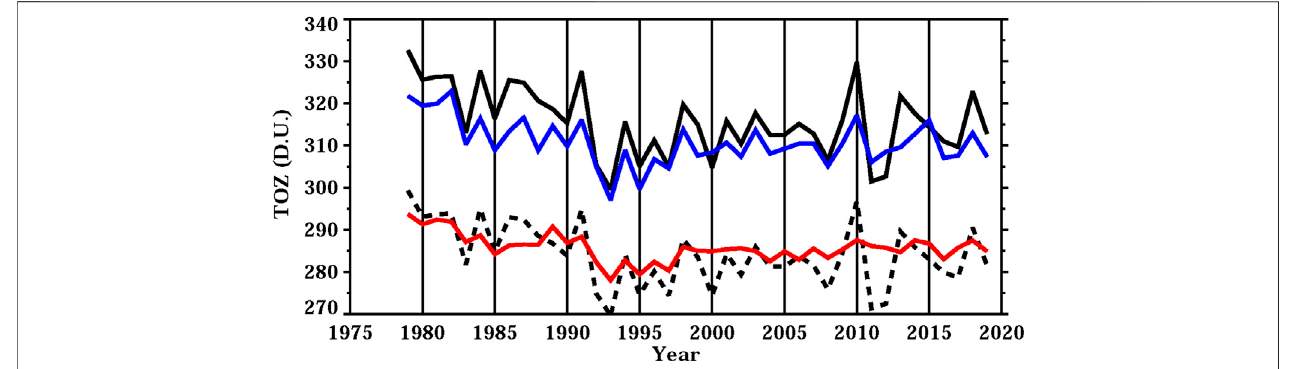
FIGURE5| AnnualmeanTCOevolutionfromArosa/DavosTCOmeasurements(blacklines),near-global(redline),andnorthernhemisphere(blueline)meansfrom the MSR2 data. The black dashed line shows Arosa/Davos TCO scaled by 0.9. The correlation coef fi cients are 0.74 for the near-global and 0.87 for the northern hemisphere